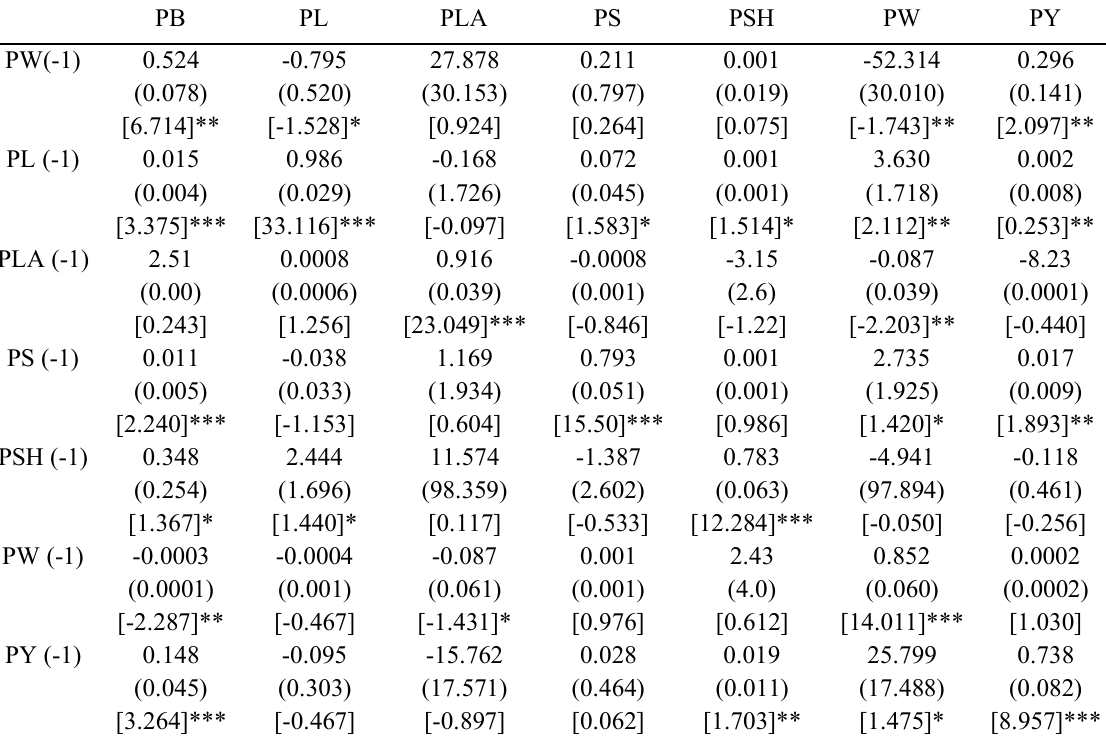
Table 4. Results of model estimation by vector auto-regression method for cotton crop PB PL PLA PS